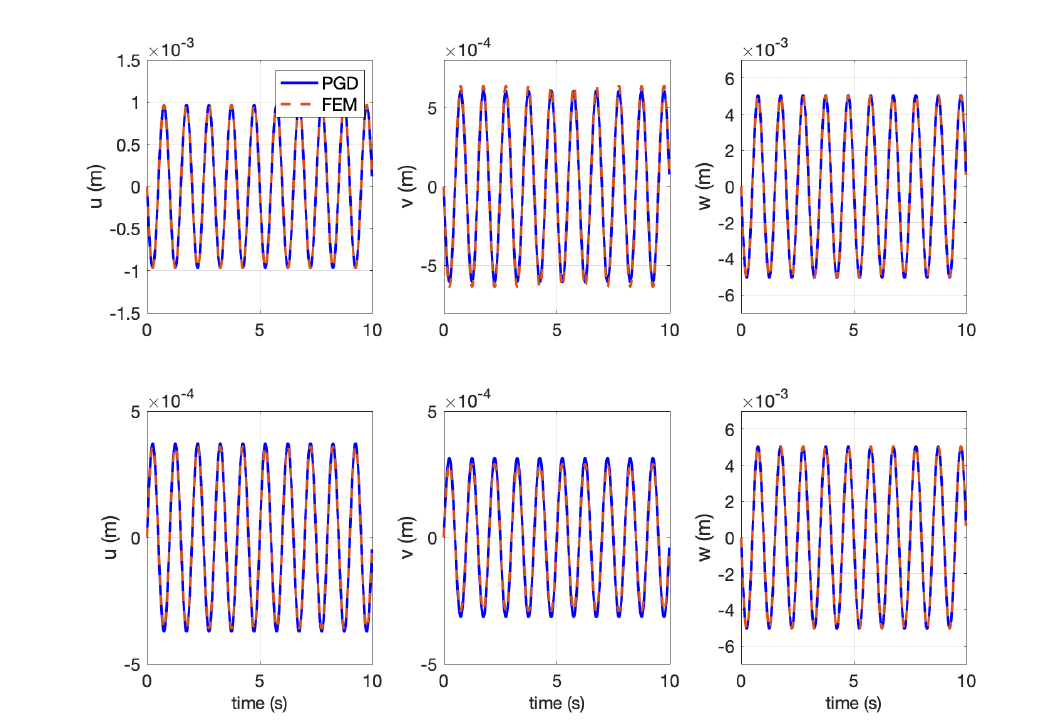
Figure 3. Displacement field ( u , v , w ) versus time at the mid-depth of the top layer (top) and bottom layer (bottom). As this figure aims to compare finite element method (FEM) and Proper Generalized Decomposition (PGD) solutions, due to the significant differences of the displacement values, for the sake of clarity, different scales are considered in each